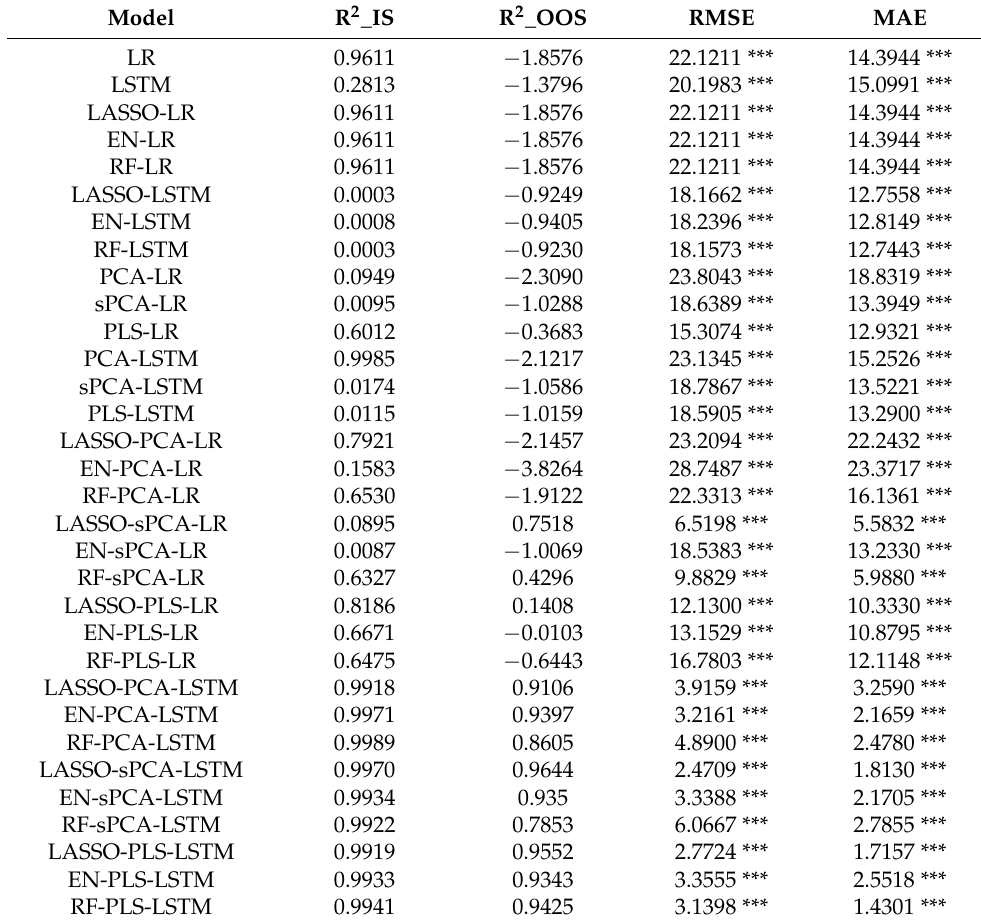
Table 5. Forecast results.